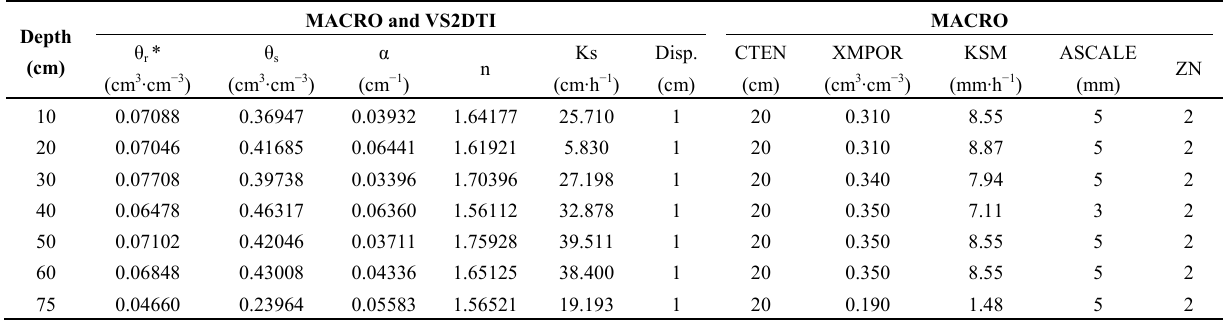
Table 4. Model parameters used in the modeling